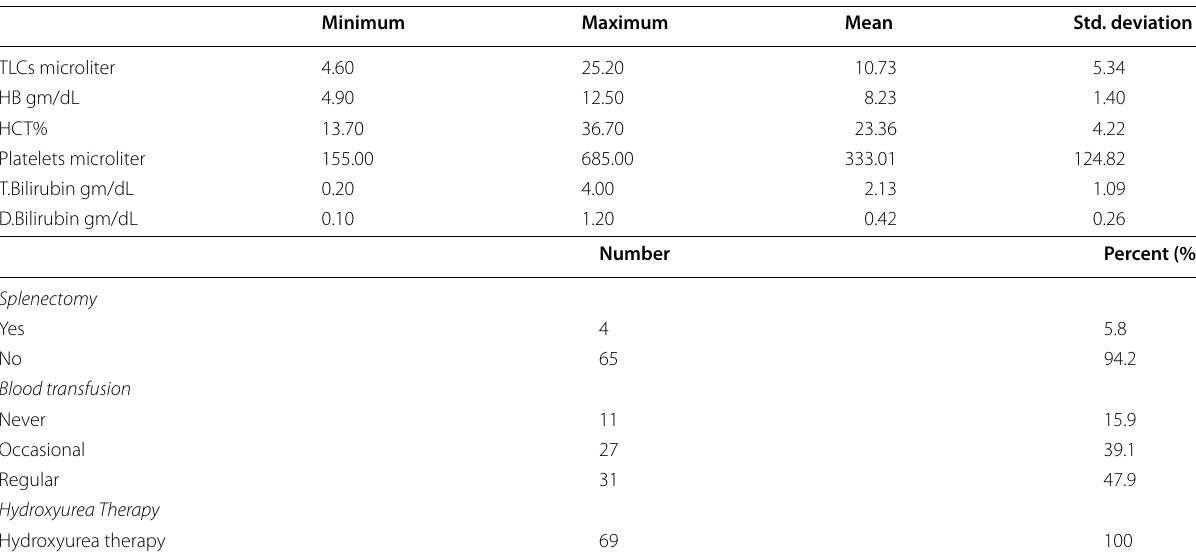
Table 1 Clinical and laboratory data of patients